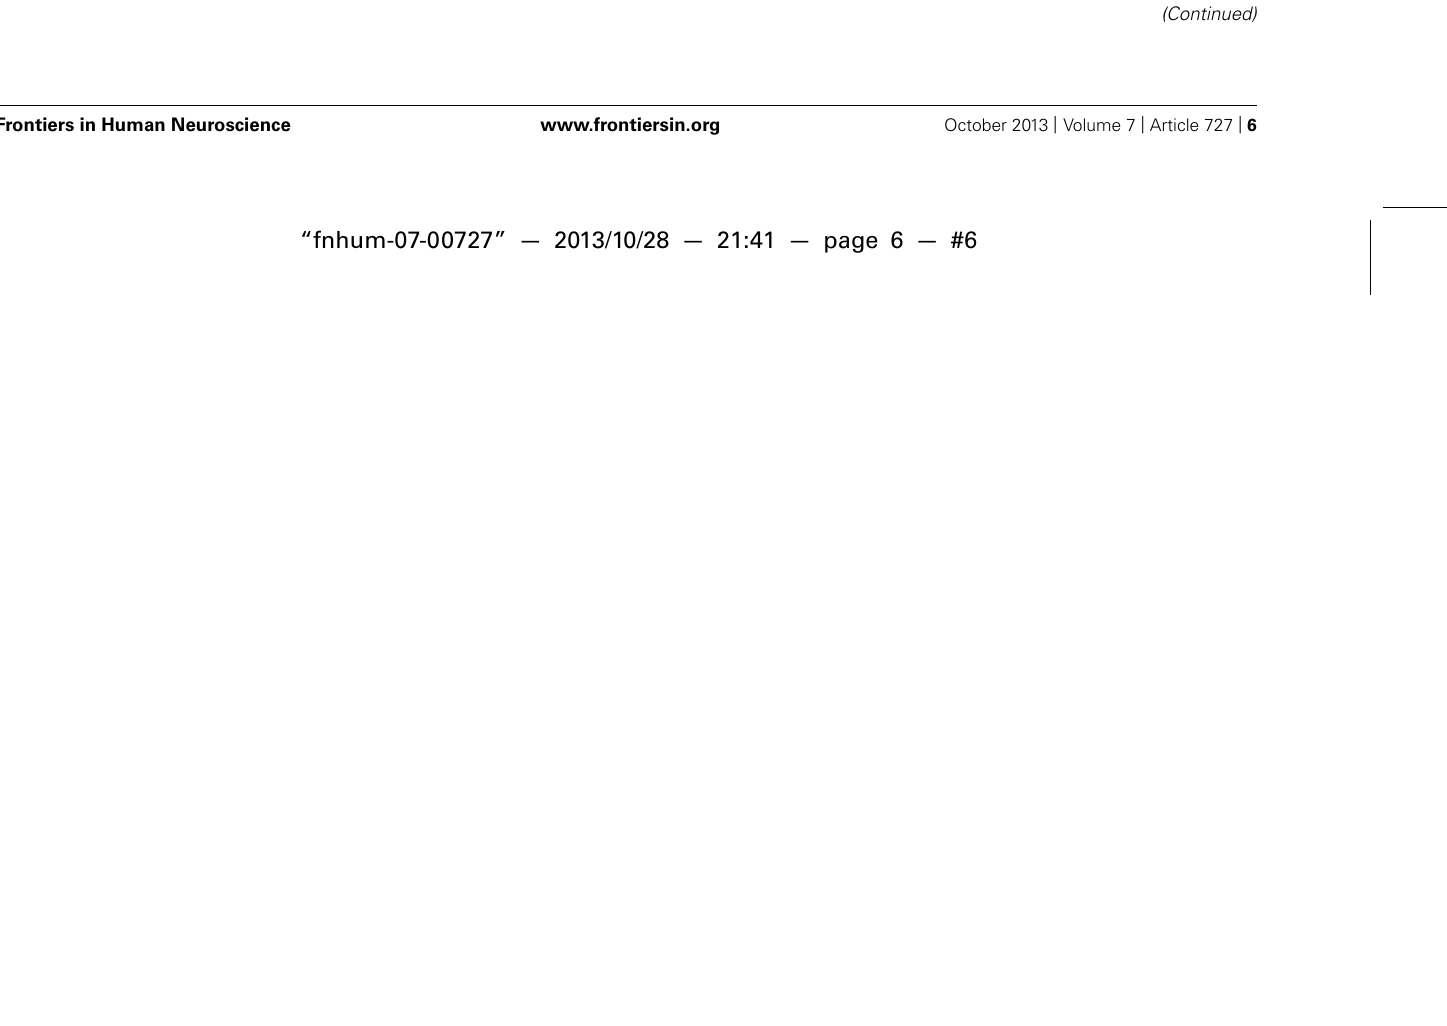
Table 3 | Spatial intra-iFC maps of DMN, SN, and CEN in controls and patients. Networks and brain